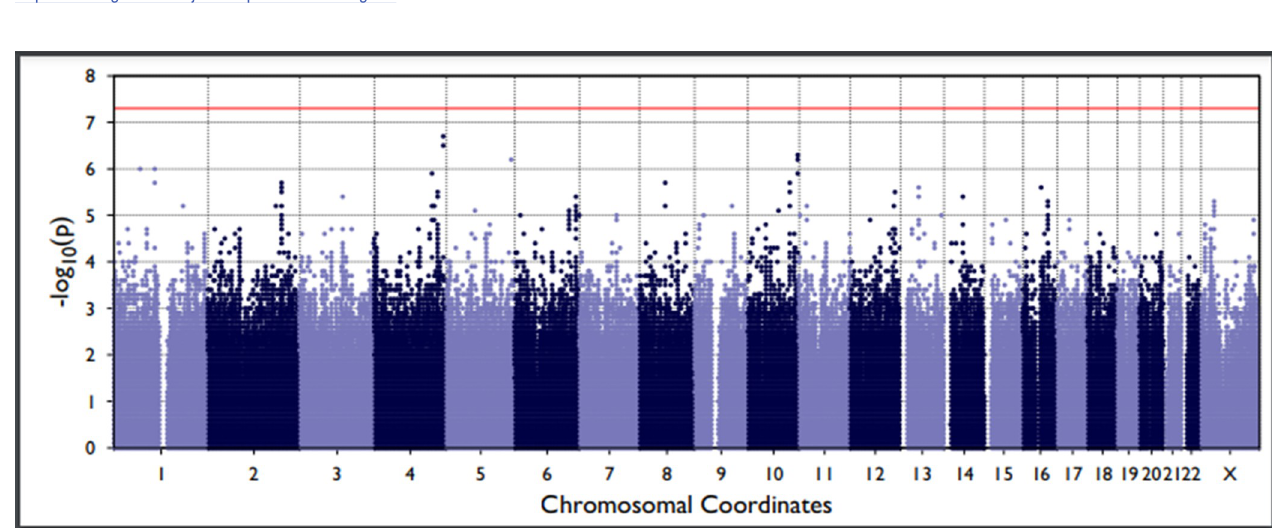
Fig 3. Manhattan plot showing the single nucleotide polymorphisms and their univariate p-values for Sepsis-2.